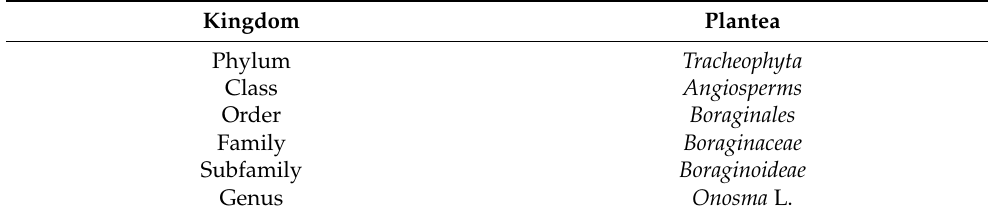
Table 1. Onosma taxonomy according to Global Biodiversity Information Facility